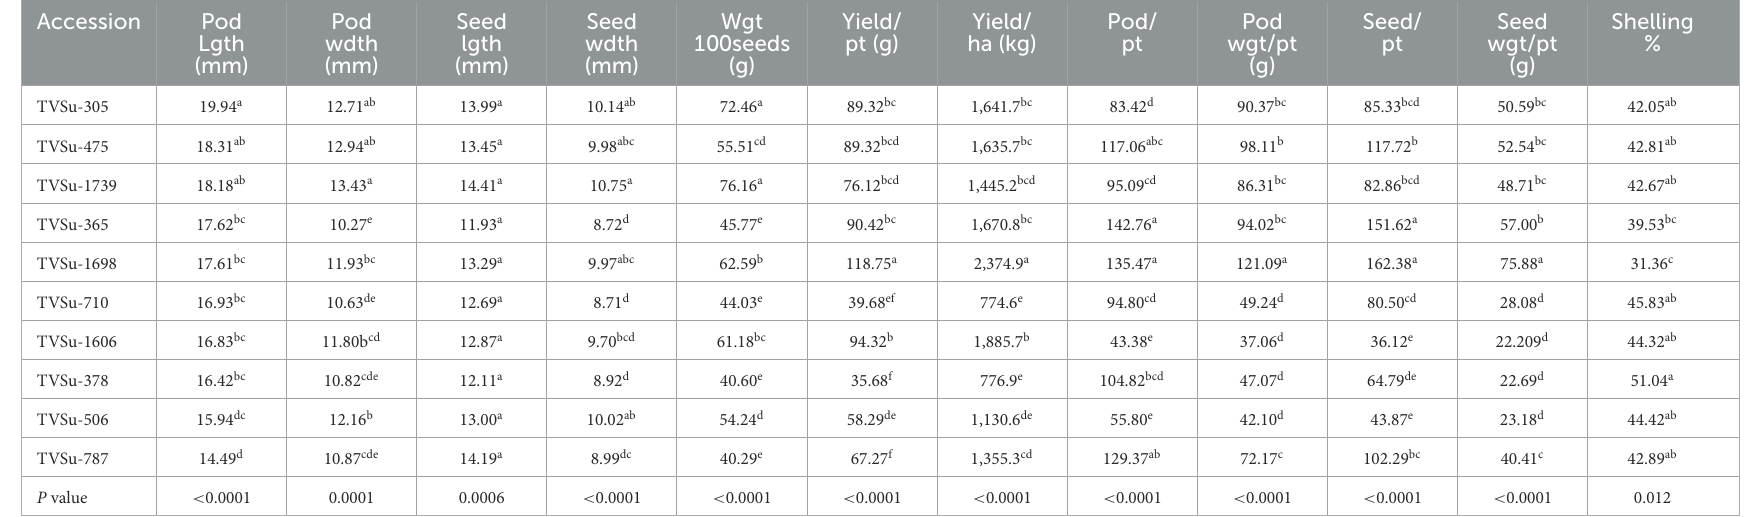
TABLE 5 Effects of treatments on yield and yield components of BGN accessions in Ibadan and Ikenne in the 2019 cropping season.